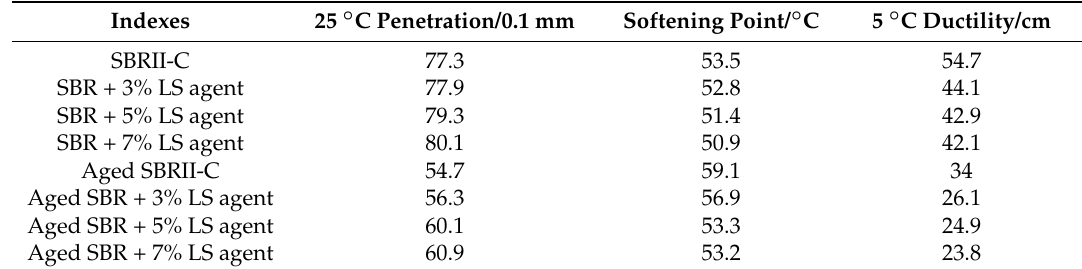
Table 6. Asphalt indexes